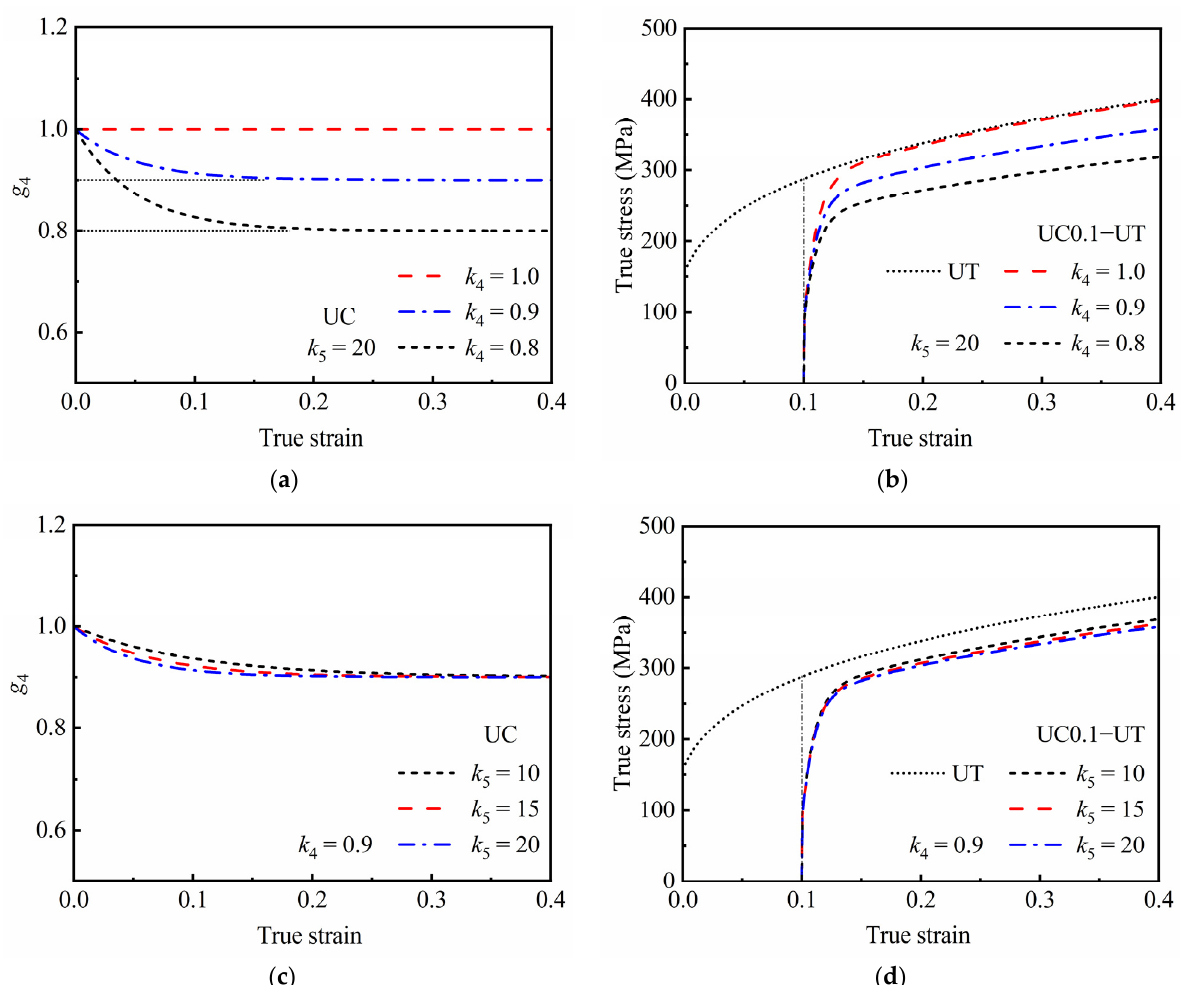
Figure 7. Predicted responses of permanent softening effect during reverse loading; evaluation of g 4 during UC loading under ( a ) different k 4 and ( c ) different k 5 ; and stress–strain curves during UC0.1 − UT loading under ( b ) different k 4 and ( d ) different k 5 .